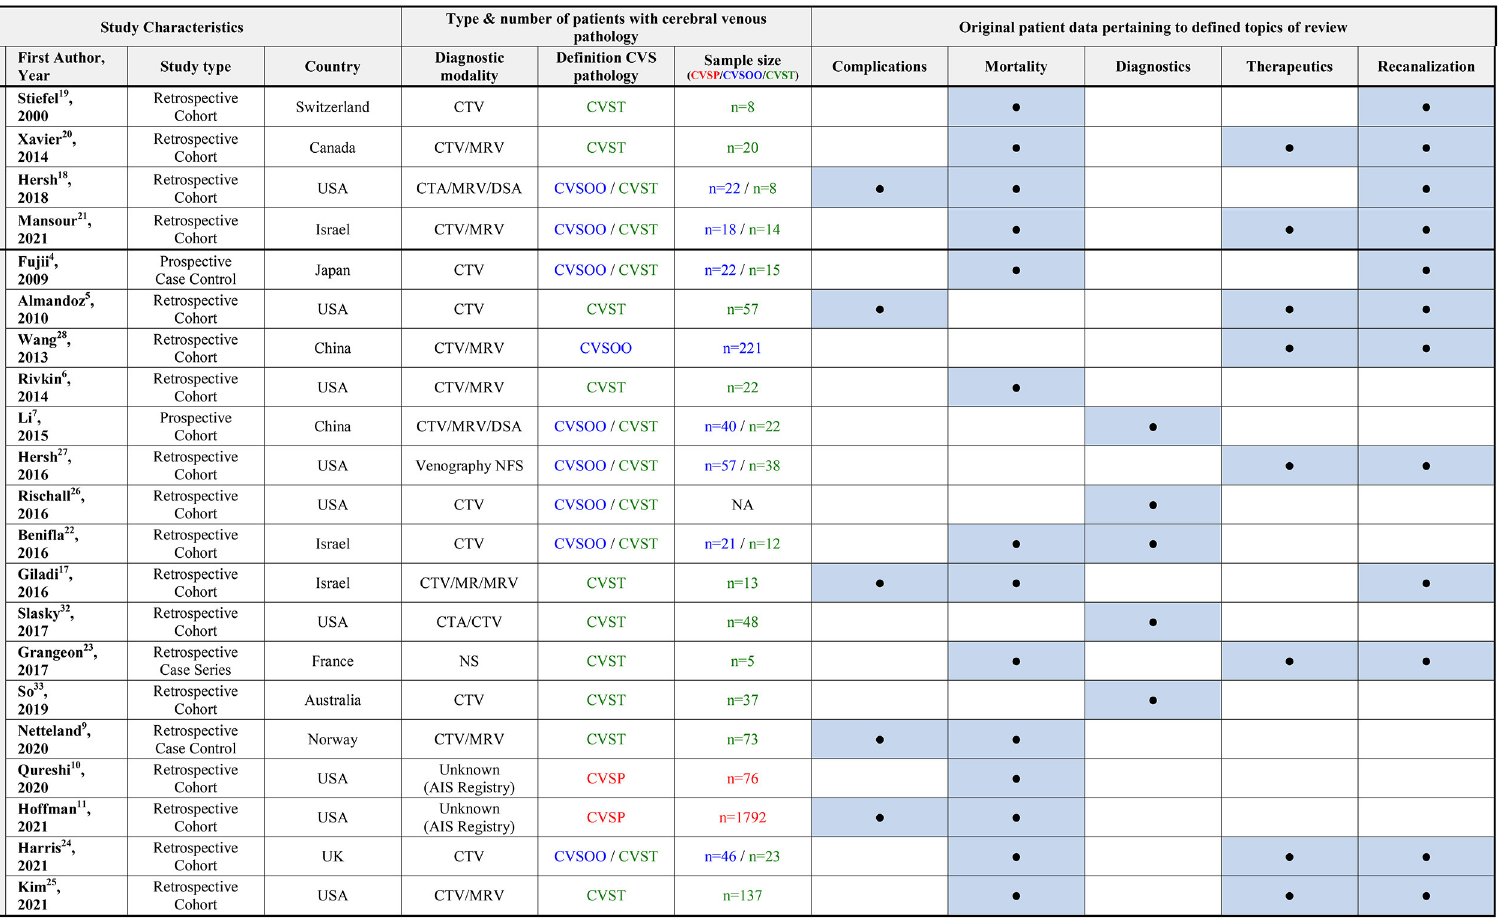
TABLE 2 Overview of included